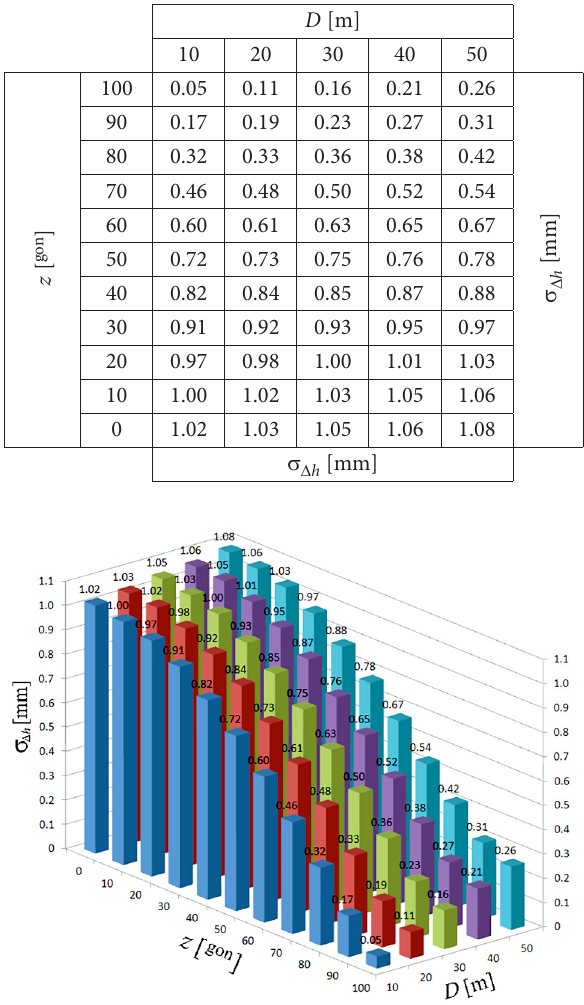
Figure 3. Graphical illustration of the accuracy h D s of determining the height difference h D by the Leica Viva